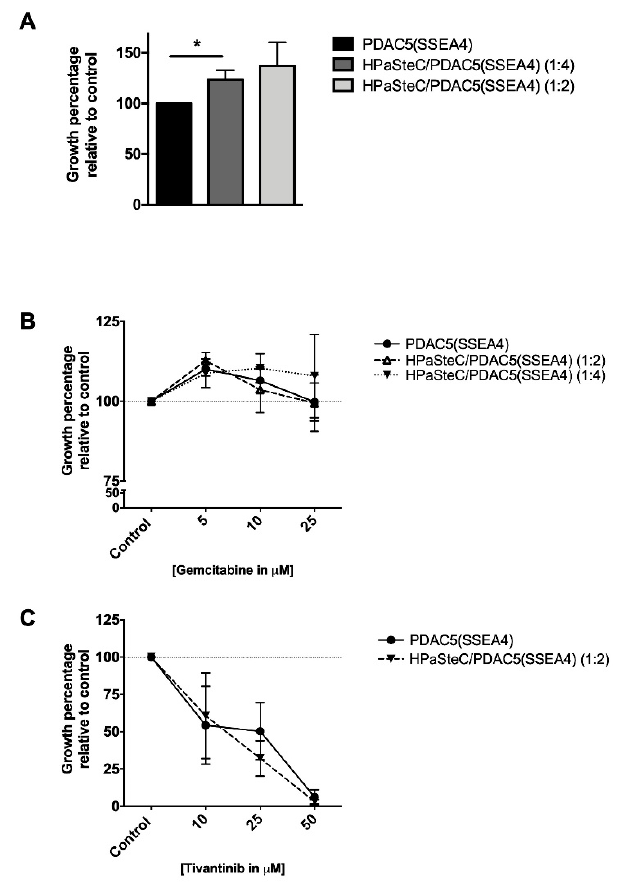
Figure 8. Effect of primary human pancreatic stellate cells (HPaSteC) on proliferation and drug response of primary PDAC5 cells sorted for SSEA4 (PDAC5 (SSEA4)) in 3D culture determined by luciferase assay. PDAC5 (SSEA4) cells alone or mixed with HPaSteC at different ratios were grown in 96-well cell repellant plates as described in Figure 6 and Supplemental Figure S7. HPaSteC cells significantly increased PDAC5 (SSEA4) cell growth in hetero-spheroids ( A ). Homo- and hetero-spheroids were treated with gemcitabine ( B ) or tivantinib ( C ) for 3 days and cancer cell proliferation was assessed by the luciferase assay. The drugs were tested in duplicate wells and the data represent the mean ± standard error of mean (S.E.M.) of three experiments (*: the difference between the hetero-spheroid and homo-spheroid consisting of the same number of cancer cells was considered significantly different at p < 0.01). Abbreviations: PDAC, pancreatic ductal adenocarcinoma; SSEA4, stage specific embryonic antigen-4; PSC, pancreatic stellate cells.